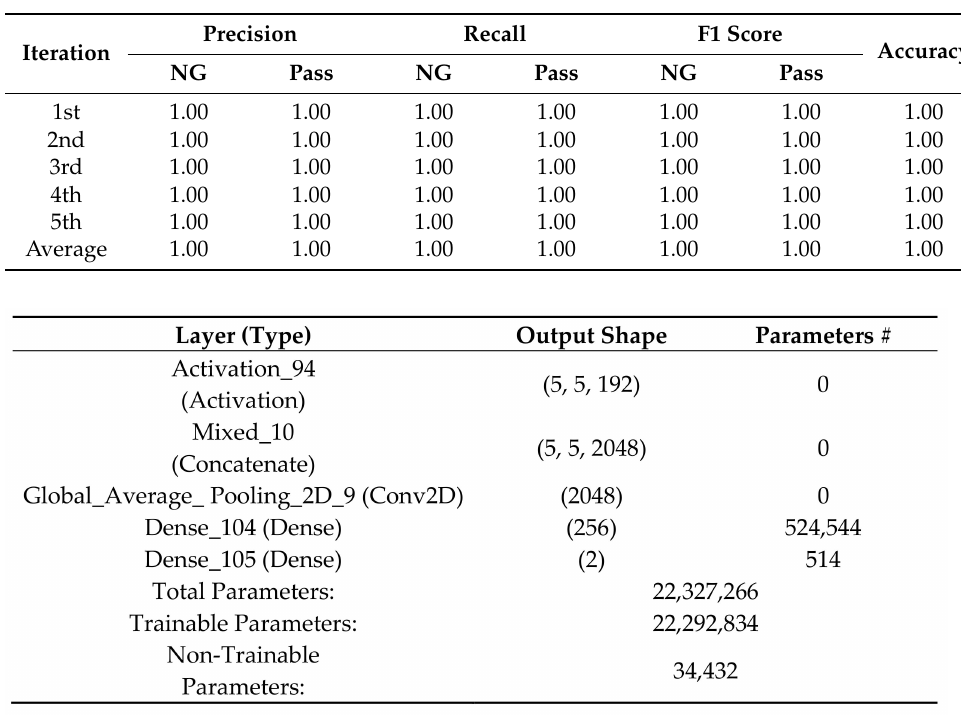
Figure A1. MobileNet + GAP Layers Configuration. Table A2. MobileNet + GAP with K-fold Iterations